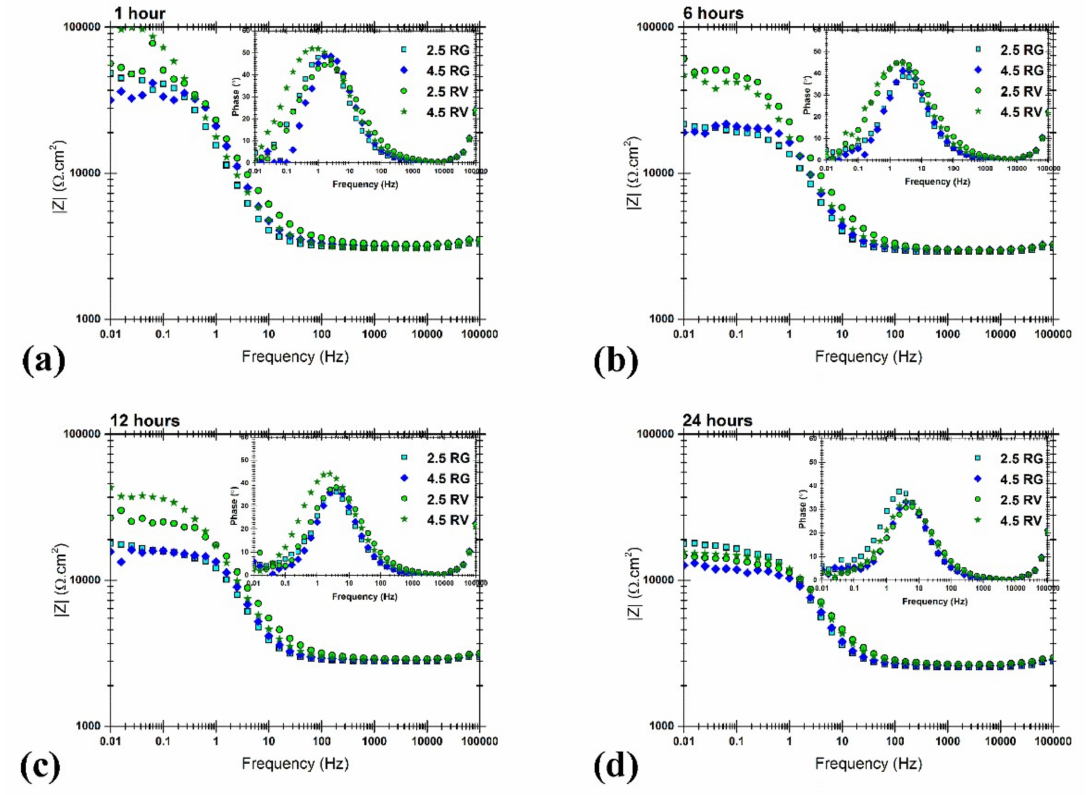
Figure 12. Bode plots of EIS spectra of samples 2.5 RG, 4.5 RG, 2.5 RV, and 4.5 RV after ( a ) 1 h; ( b ) 6 h; ( c ) 12 h; and ( d ) 24 h of immersion in the diluted Harrison